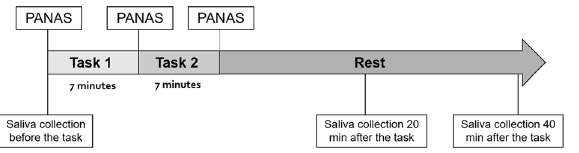
Figure 1. Outline of the experimental